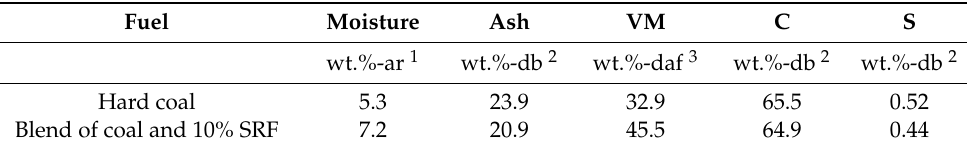
Table 1. Properties of the feed fuels used in this study (after Wasielewski et al., [23]) (VM: Volatile matter, C: Carbon, S: Sulfur).